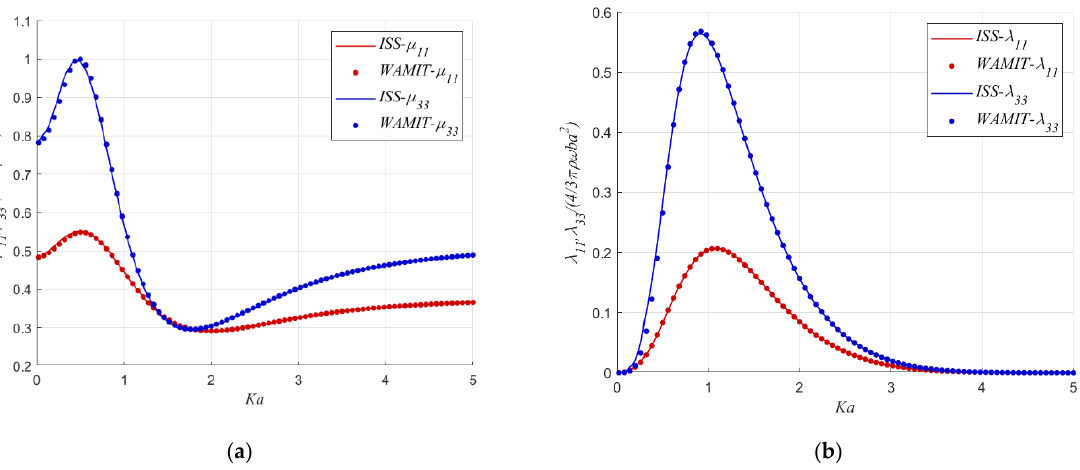
Figure 4. Normalized hydrodynamic coefficients in heave and surge for a/b = 1.25, f = 1.1a and h = 5a: ( a ) added mass; ( b ) hydrodynamic damping.